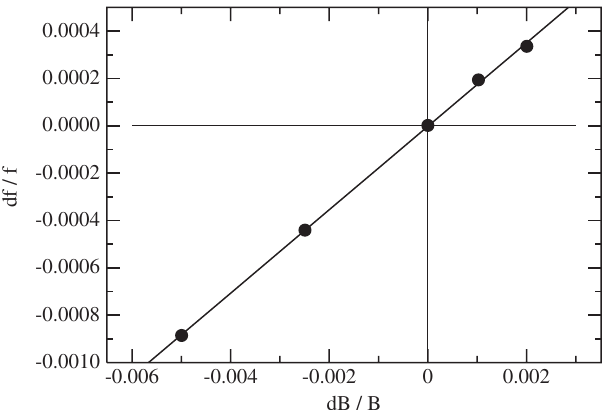
FIG. 1. Measurements of the fractional change in the cyclotron frequency as a function of the fractional change in the magnetic field. The best fit slope is a measure of the momentum compac- tion